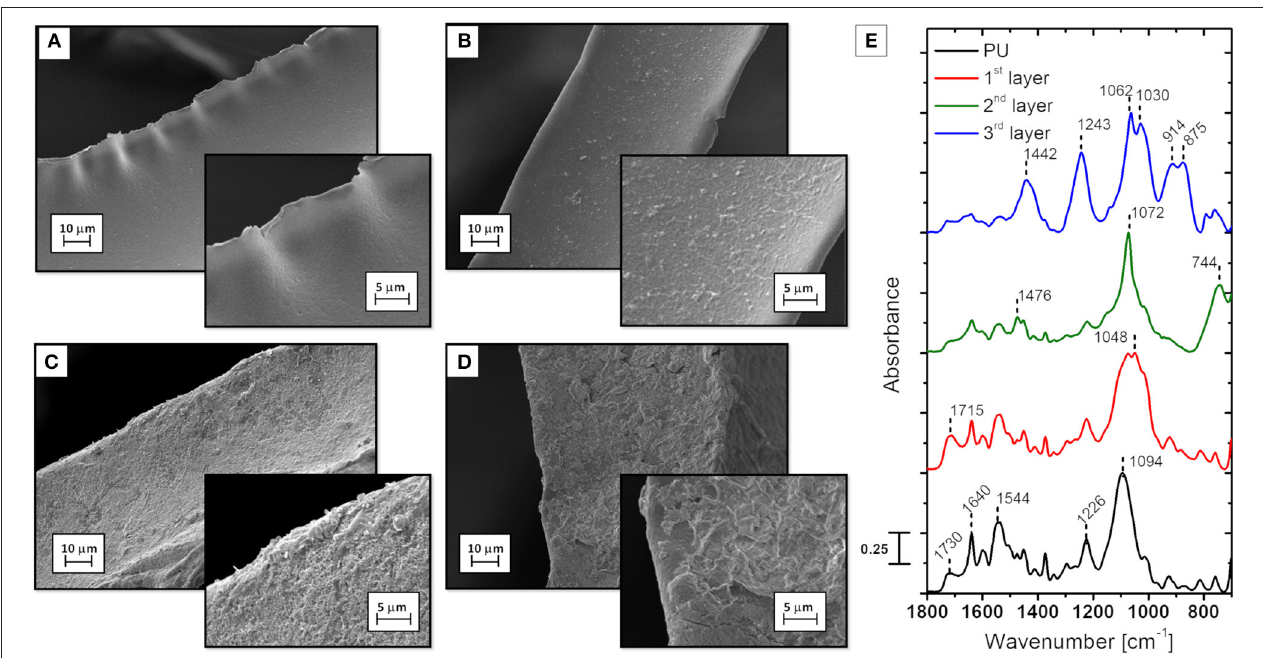
FIGURE 2 | SEM micrograph of untreated and treated PU foam (main: 1000X, inlet: 2500X): (A) neat PU, (B) 1st layer, (C) 2nd layer, (D) 3rd layer, and (E) ATR spectra of neat PU and PU coated with 1, 2, and 3 layers.